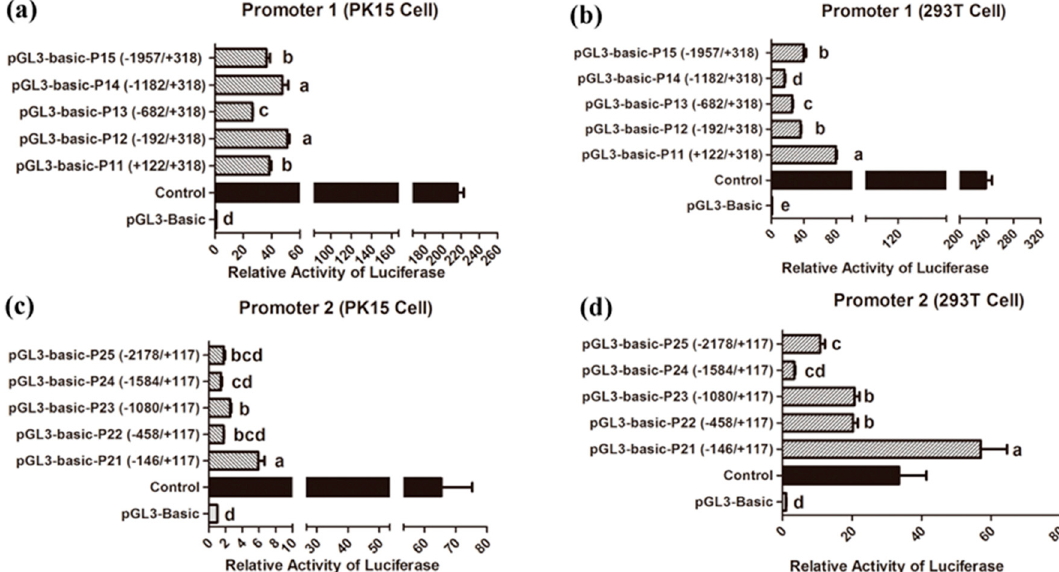
Figure 6. Promoter activity analysis for the two transcript variants of porcine Prox1 . Promoter activity analysis for Prox1 transcript variant 1 (Promoter 1) in PK15 cells ( a ) and 293T cells ( b ). Promoter activity analysis for Prox1 transcript variant 2 (Promoter 2) in PK15 cells ( c ) and 293T cells ( d ). The left side of the x-axis represents a series of truncated 5 ′ -flanking sequences of Prox1 that were fused to the firefly luciferase reporter gene in the pGL3-basic vector, and their positions were defined relative to the transcription start site (+1) of porcine Prox1 . The right side of the x-axis indicates the relative luciferase activity of promoter fragments. Here, pGL3-basic and -control were the negative and positive control vectors, respectively. The pRL-TK vector encoding Renilla luciferase was co-transfected as the internal reference. Promoter activity was defined by the normalization of firefly luciferase activity to Renilla luciferase activity, and the value of pGL3-basic negative vector was defined as 1. Data are presented as the mean ± SEM (n = 5). Statistical analysis was performed in SPSS 20.0 using one-way ANOVA test with Duncan’s multiple range tests. Data are presented as the mean ± SEM (n = 5). Different letters above the bars indicate significant differences. Note: p < 0.05.